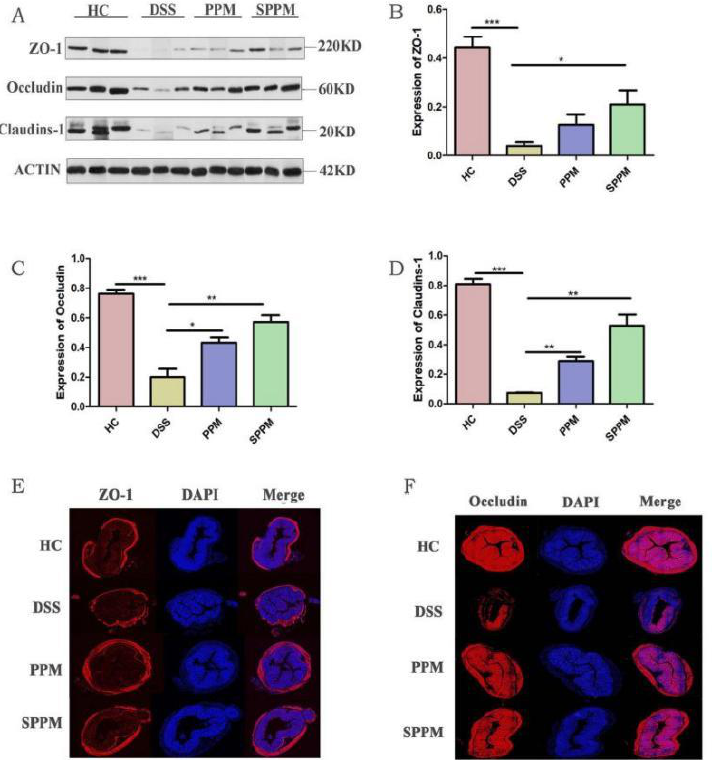
Figure 5. Effects of PPM60-III and SPPM60-III on tight junction protein in mice. ( A ) Western blotting; ( B – D ) protein expressions levels of ZO-1, occludin, and claudins-1; ( E ) ZO-1; ( F ) occludin. * p < 0.05, ** p < 0.01, *** p < 0.001.